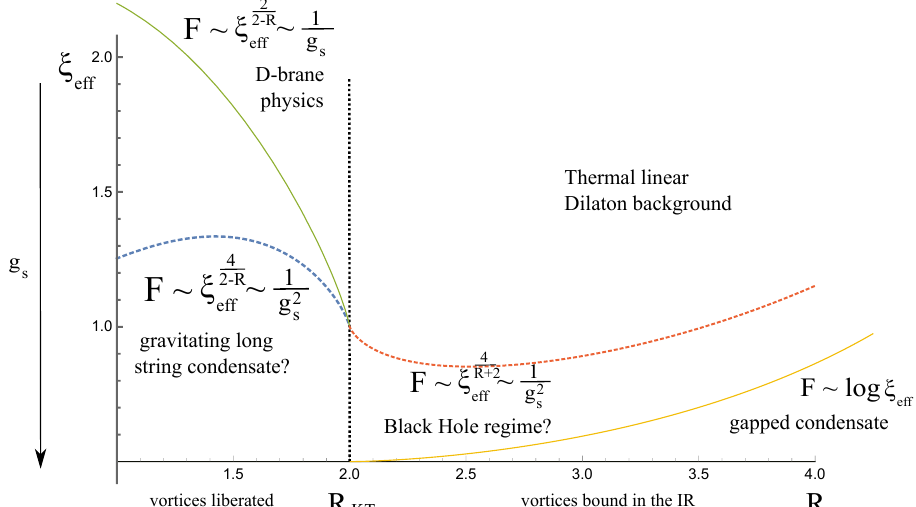
Figure 7 . The phase diagram. The dashed lines signal phase transitions. T KT ∼ 1 /R KT is the Kosterlitz-Thouless temperature, above which worldsheet vortices get liberated and proliferate in the IR. The continuous lines do not signal phase transitions, but are regimes of different behaviour (cross-over). The question-mark in the gravitating long string condensate phase, has to do with the fact that one needs additional probes to distinguish the location of the black hole string crossover, since the scaling of the free energy and entropy for R < R is consistent with both interpretations. KT The scaling of the free energy in the black hole regime for R > R reveals an opposite type ( + ) KT of dressing for the winding modes, that become normalisable and have support in the strongly coupled region of Liouville. This means that a black hole can start existing as an excited state in the spectrum of the theory. This region though, becomes increasingly narrower as R → ∞ and is replaced by a non-singlet object whose free energy is logarithmically gapped compared to the singlet. The question mark in the black hole phase for R > R has to do with the fact that we would KT like to understand the fate of the favourable critical region, when we turn on also a non-zero µ (a third